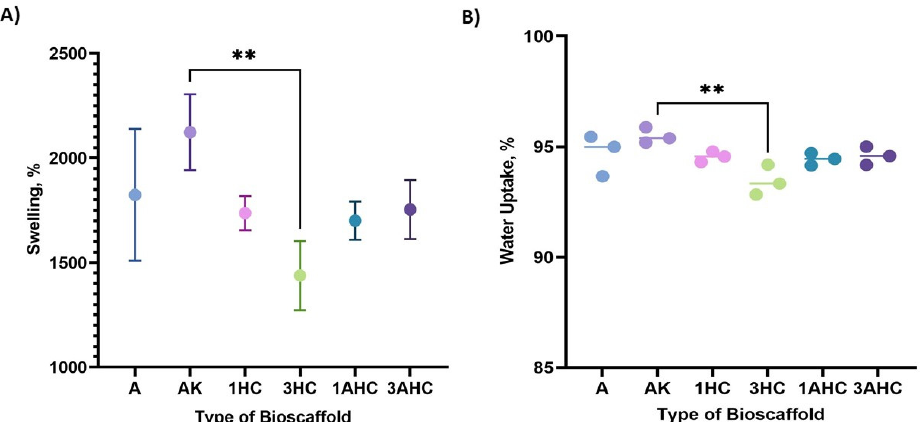
Figure 7. ( A ) Swelling capabilities and ( B ) water uptake of bioscaffold results. The dots on the graph represent individual value of each sample in the group. The statistical significance was considered at a probability of p < 0.05 (** p ≤ 0.01.